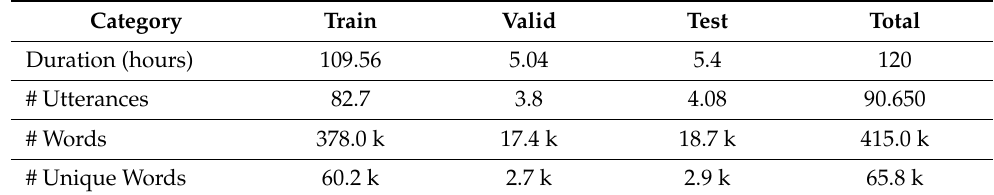
Table 3. The dataset